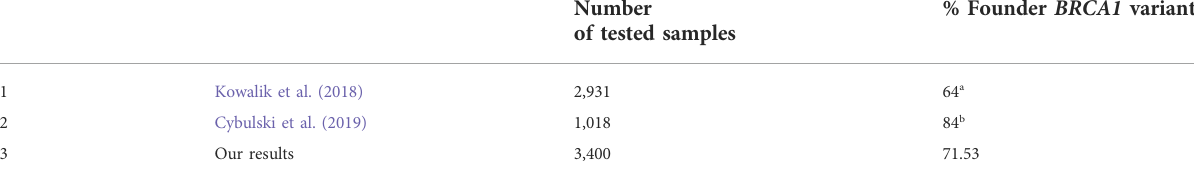
TABLE 2 Comparison of test results from other regions of Poland obtained in other genetic laboratories in